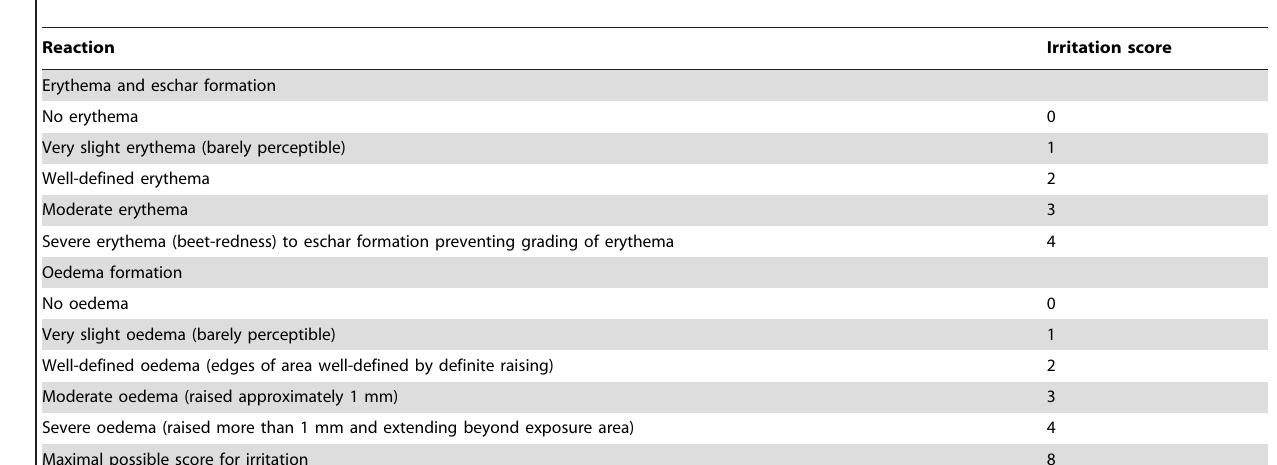
Table 1. Scoring system for skin reaction [23].